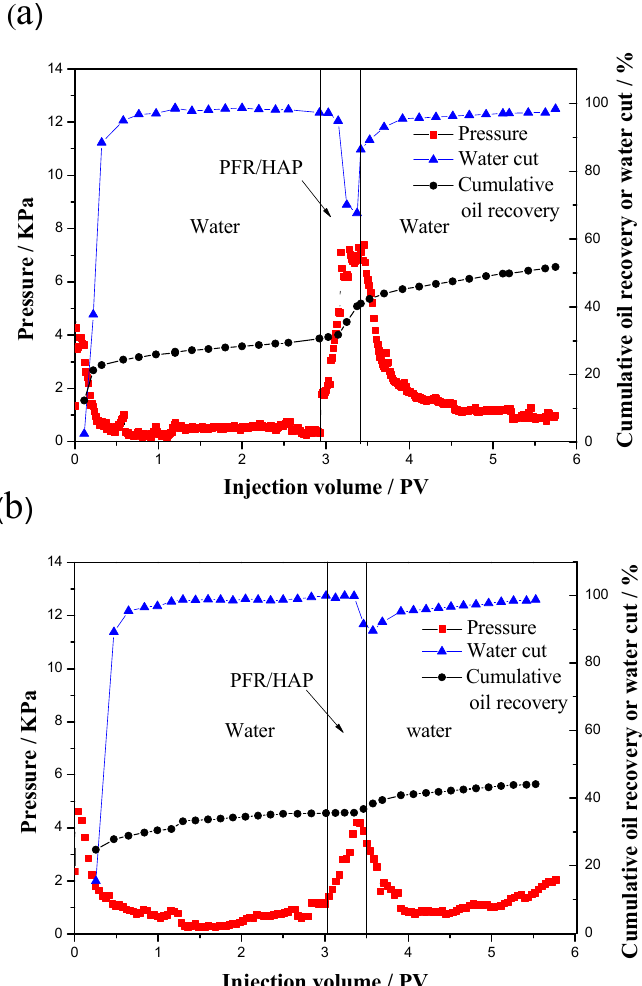
Figure 9. Pressure, water cut and cumulative oil recovery as a function injected volume for PFR/HAP dispersion flood of parallel sand packs (( a ): test4; ( b ): test5).